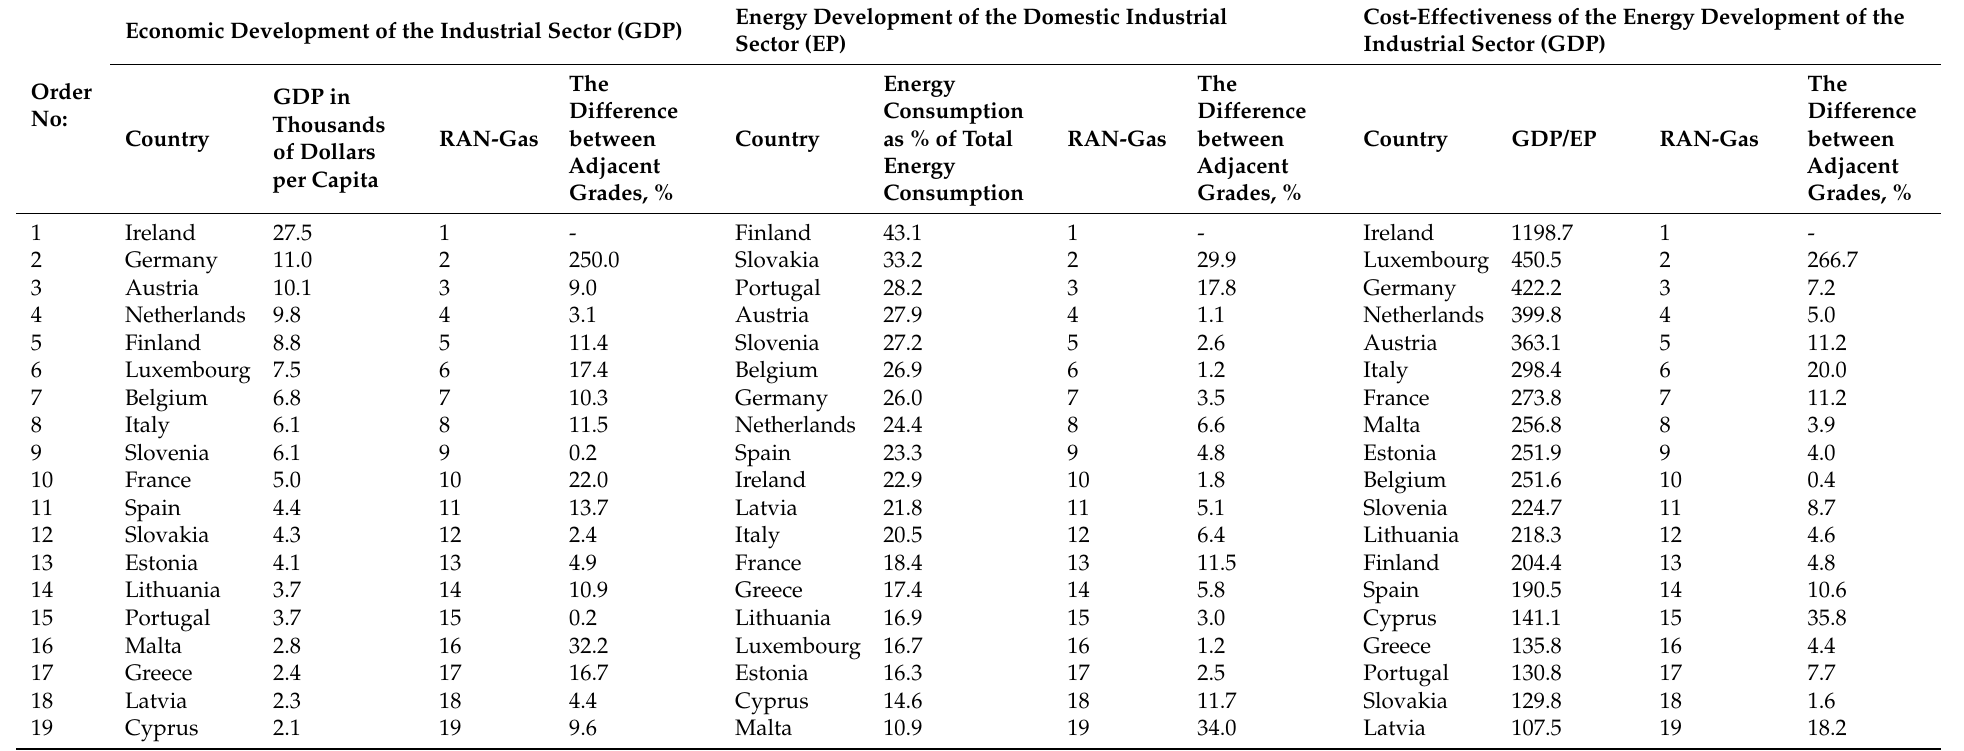
Table 2. Cost-effectiveness of the energy development of the industrial sector in the euro area countries in the European Union in 2018 (source: compiled by authors based on